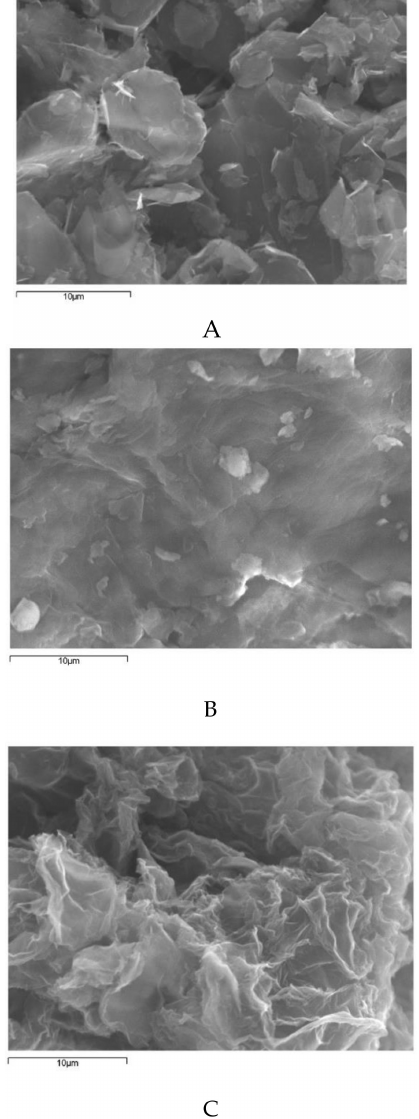
Figure 4. FEG-SEM, 3500 × , JEOL JSM-6400 image of ( A ) xGnP-H, ( B ) xGOnP, ( C ) rxGOnP.